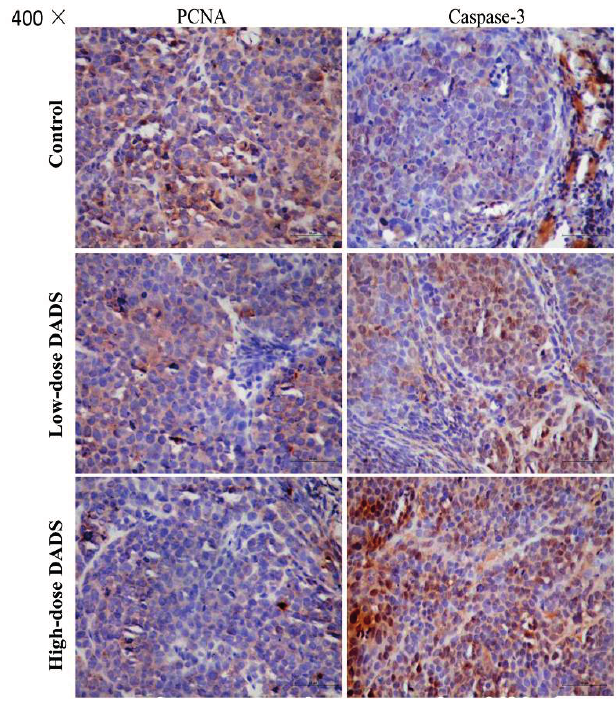
Figure 5. Anti-proliferative and pro-apoptotic effects of DADS on ECA109 xenograft tumors. Tumors from the negative control group, 20 mg/kg DADS group and 40 mg/kg DADS group were processed for immunohistochemical staining of proliferation cell nuclear antigen (PCNA) ( a , b ) and caspase-3 ( a , c ). A representative picture had been shown for each case. Immunoreactive cells (yellow to brown) in xenograft tumors were enumerated and analyzed by Image-Pro Plus analysis system (Media Cybernetics, Bethesda, MD, USA) linked to an Olympus microscope (Olympus Corporation, Center Valley, PA, USA). The total number of cells was presented from all the samples in each group of five randomly selected microscopic fields. The data are expressed as the mean ± SD (×400) (** p < 0.01 compared with the control